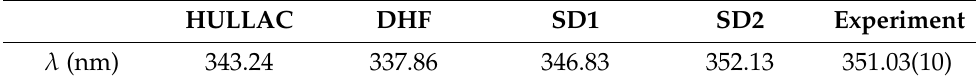
Table 2. Calculated wavelengths ( λ ) for the transition [( 4 d − 2 W 29 + . DHF stands for the wavelength obtained with the reference CSF 4 d 8 4 f ( N C SF = 5 ) , SD1 the result with the CSF expansion in the first layer { 4 p ,4 d ,4 f } ( N C SF = 3468 ) , and SD2 the result with the expansion including the second layer { 5 s ,5 p ,5 d ,5 f ,5 g } ( N C SF = 175,140). HULLAC stands for the wavelength value in the CR model (Figure 4) calculated by HULLAC code. HULLAC DHF SD1 SD2 Experiment λ (nm) 343.24 337.86 346.83 352.13